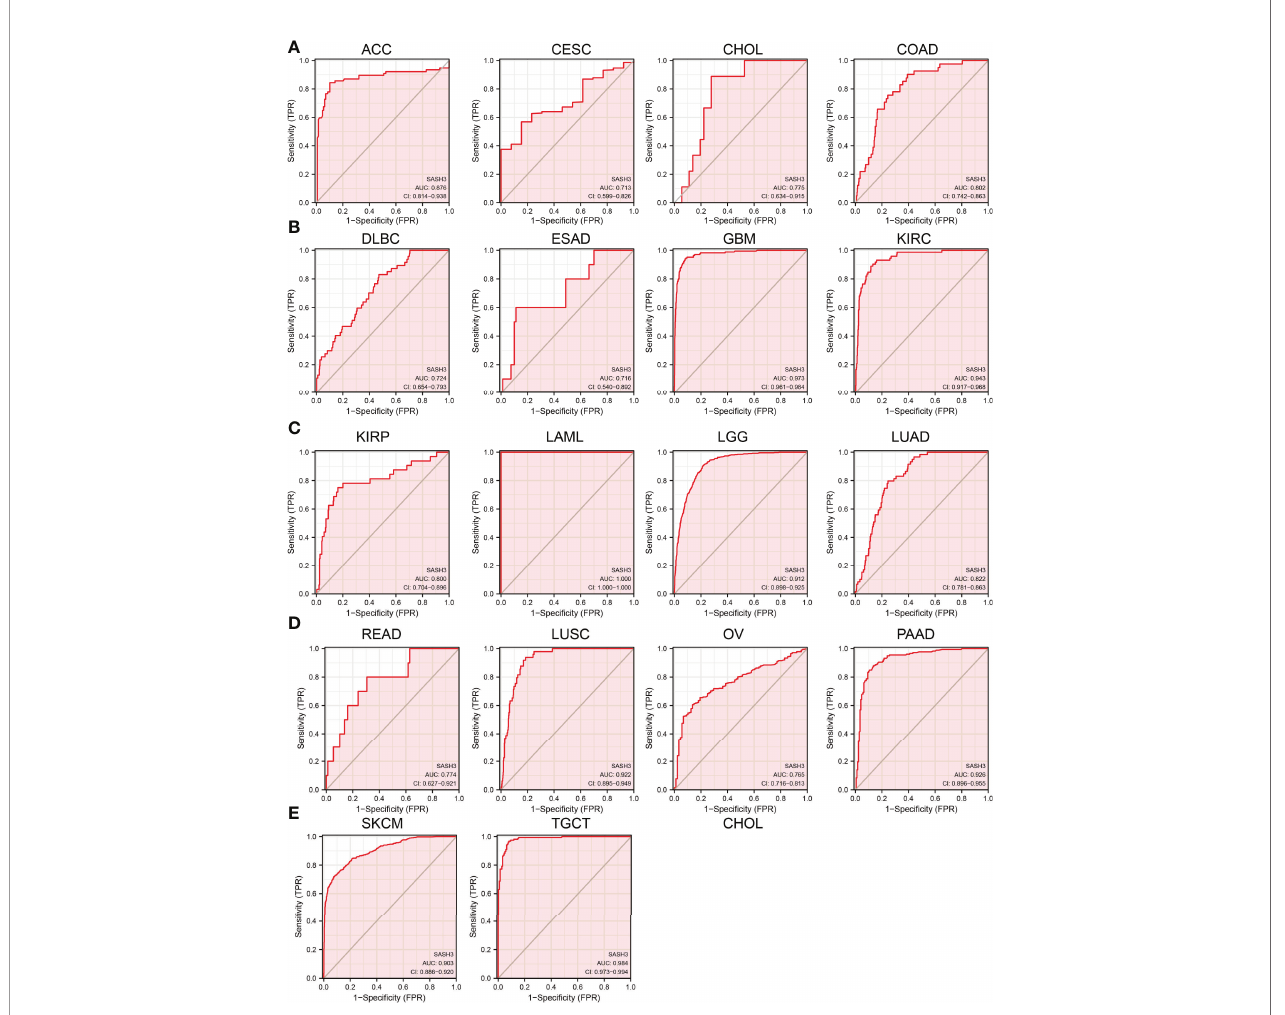
FIGURE 5 | SASH3 may act as a potential biomarker in human cancer. Predictive power for prognosis with SASH3 expression by ROC curve analysis in ACC, CESC, CHOL, and COAD (A) ; DLBC, ESAD, GBM, and KIRC (B) ; KIRP, LAML, LGG, and LUAD (C) ; READ, LUSC, OV, and PAAD (D) ; SKCM and TGCT (E)